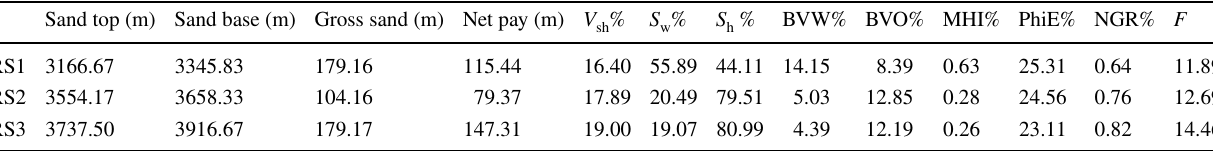
Fig. 2 Well positions indicating plotted logs. This shows the plotted well logs of the entire four wells within the study area and its corresponding reservoir units Table 1 Petrophysical properties of Well